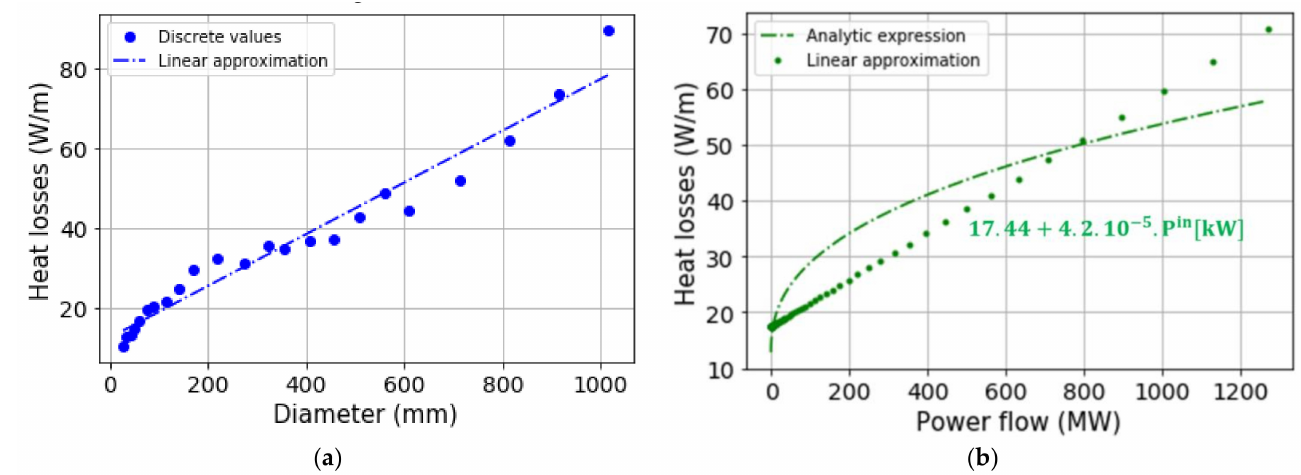
Figure 6. ( a ) Heat losses as a function of pipes diameters. ( b ) Heat losses as a function of the power